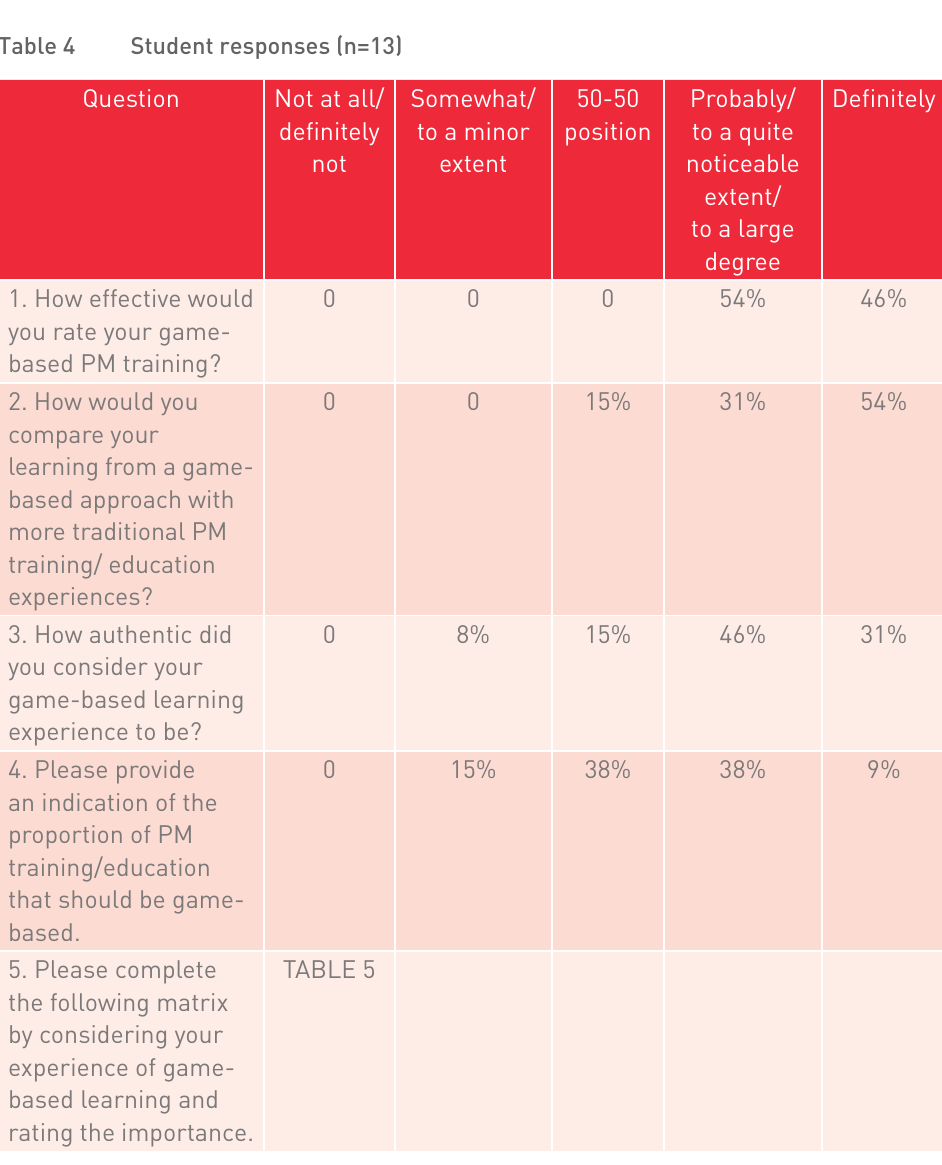
Student responses